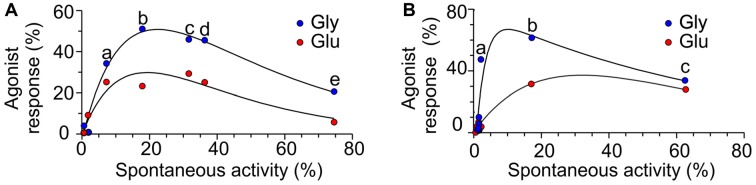
The relation between spontaneous activity and single agonist-induced responses. (A) Plot of the RISpont activity vs. RIGlu (red symbols) and RIGly (blue symbols) in receptors with single-deletion mutations in GluN1 linker (a = ΔD658; b = ΔR659; c = ΔL655; d = ΔV656; e = ΔL657). (B) Plot of the RISpont activity vs. RIGlu (red symbols) and RIGly (blue symbols) in receptors with single AA deletion mutations in GluN2B linker (a = ΔQ656; b = ΔI655; c = ΔM654).